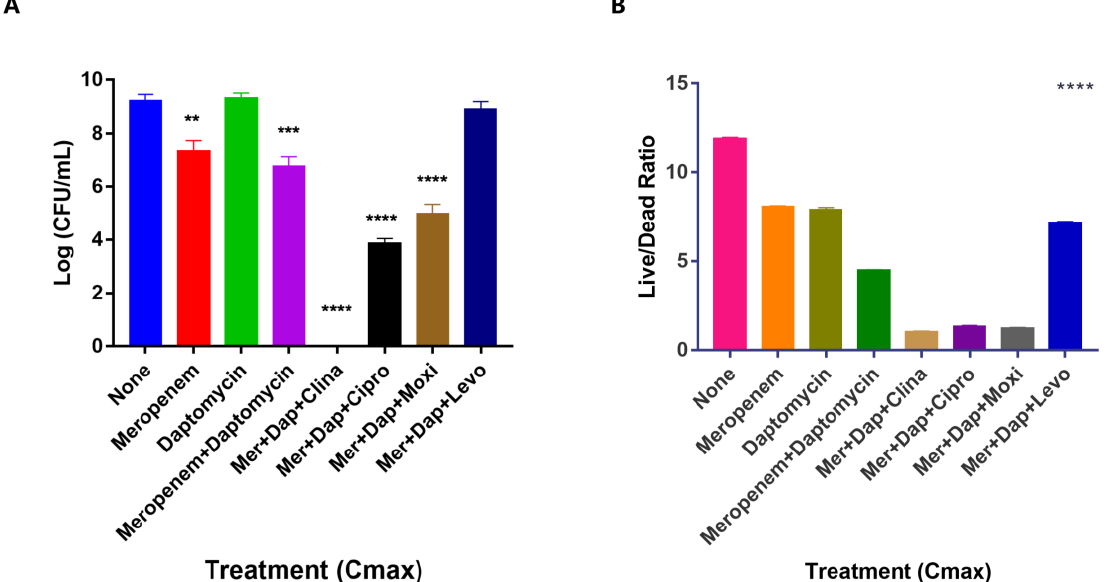
Figure 3. Ranking of fluoroquinolones in drug combinations at Cmax concentrations for activity against S. aureus USA300 biofilm bacteria. Commonly used fluoroquinolones ciprofloxacin, moxifloxacin, levofloxacin were evaluated together with clinafloxacin in combination with meropenem+daptomycin in drug exposure tests for 4 days with S. aureus Newman biofilm bacteria, when the effect of the treatment was assessed by ( A ) CFU count and ( B ) SYBR Green/PI viability assay as described in Methods. Meropenem, Mer; Daptomycin, Dap; Clinafloxacin, Clina; Ciprofloxacin, Cipro; Moxifloxacin, Moxi; Levofloxacin, Levo. One-way ANOVA and post hoc Tukey’s test was used for multiple group comparisons. ** p < 0.05, *** p < 0.005, **** p < 0.0001. Error bars indicate standard